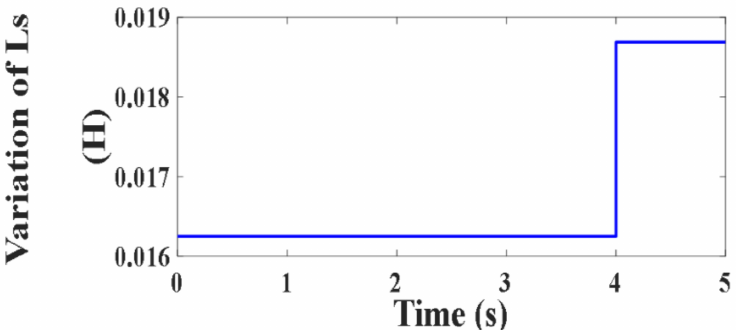
Figure 150. Variation of L s (H).